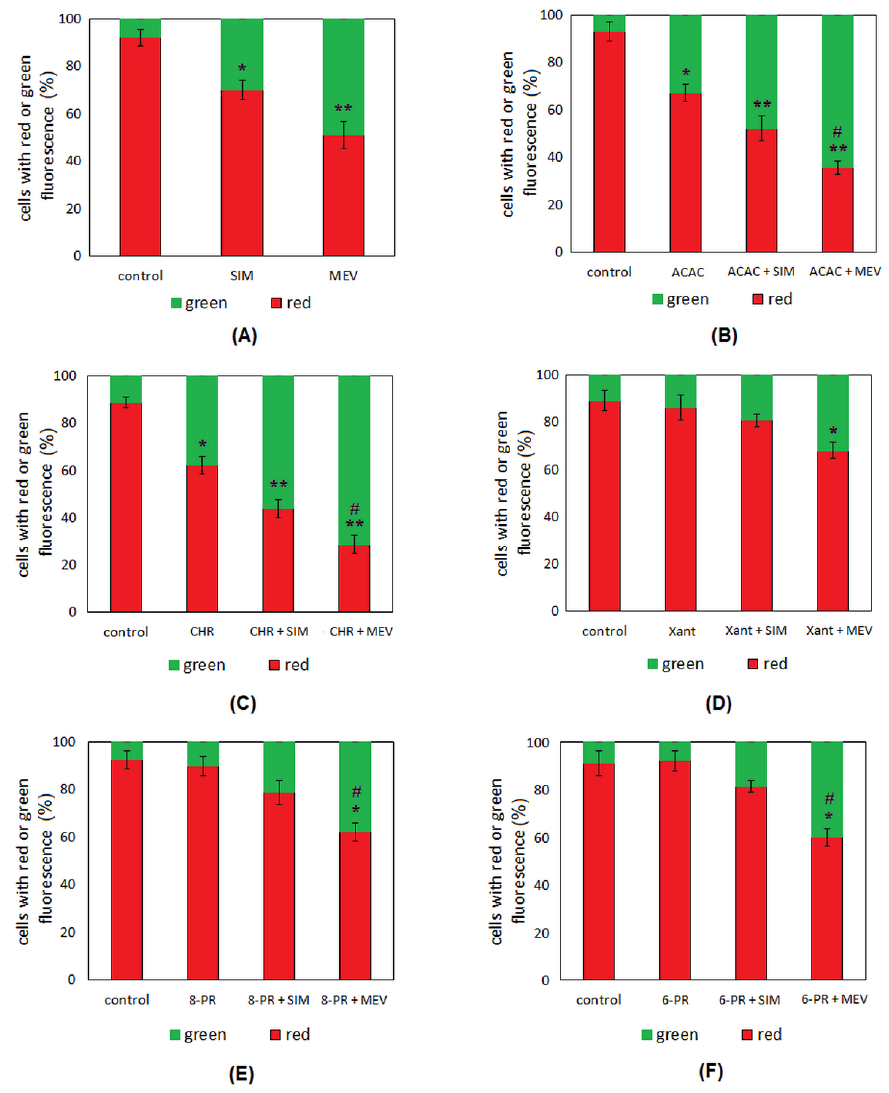
Figure 7. The mitochondrial membrane potential (MMP) of Jurkat T cells incubated for 48 h with simvastatin (SIM) or mevastatin (MEV) ( A ); flavonoid (acacetin, ACAC; chrysin, CHR; xanthohumol, Xant; 8-prenylnaringenin, 8-PR; 6-prenylnaringenin, 6-PR), and flavonoid in combination with statin (SIM or MEV) ( B – F ). MMP was expressed as a ratio of 540 nm/590 nm to 490 nm/525 nm fluorescence, as quantified with a fluorescent plate reader after JC-10 staining. Each column represents the percentage of Jurkat T cells characterized by red or green fluorescence. The results were the means ± SDs from three independent experiments. Statistical significance was determined using the Student’s t -test. We compared the results obtained for each compound/combination with the results obtained from the samples containing no compounds (* p < 0.05; ** p < 0.001). We also determined the differences between results obtained for single flavonoid and its combination with statins (# p < 0.05).